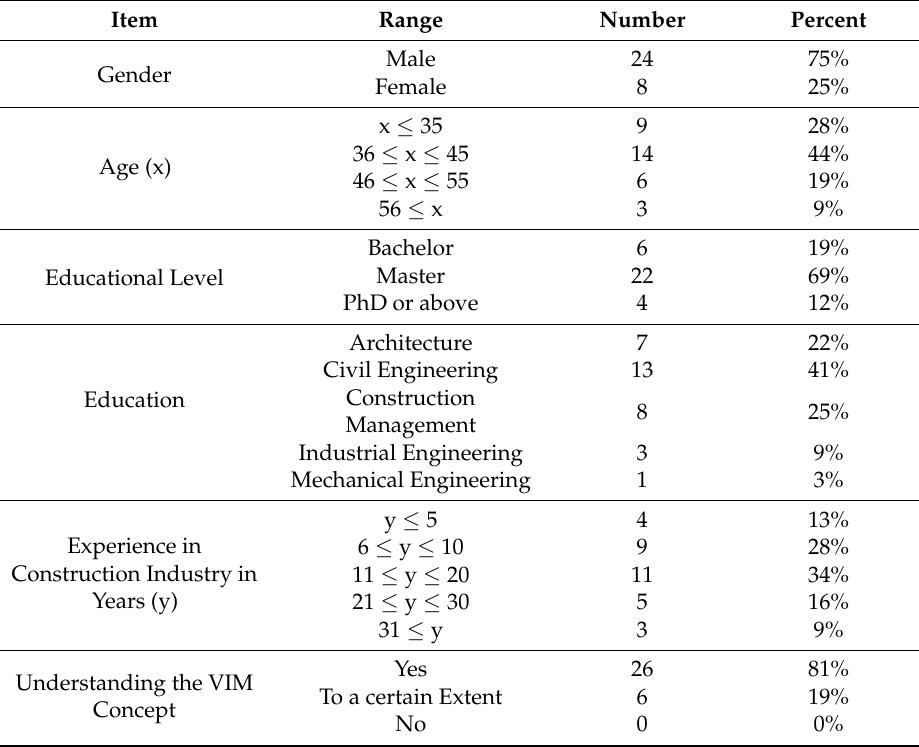
Table 3. Summary of respondents’ profile.